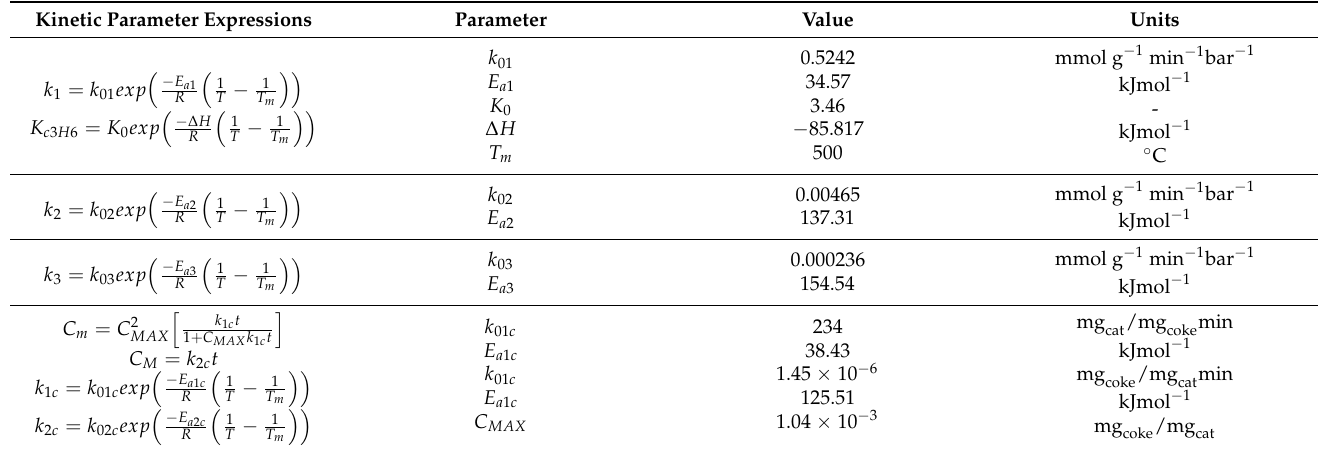
Table A2. List of kinetic parameters for the Pt-Sn-K/Al 2 O 3 catalyst